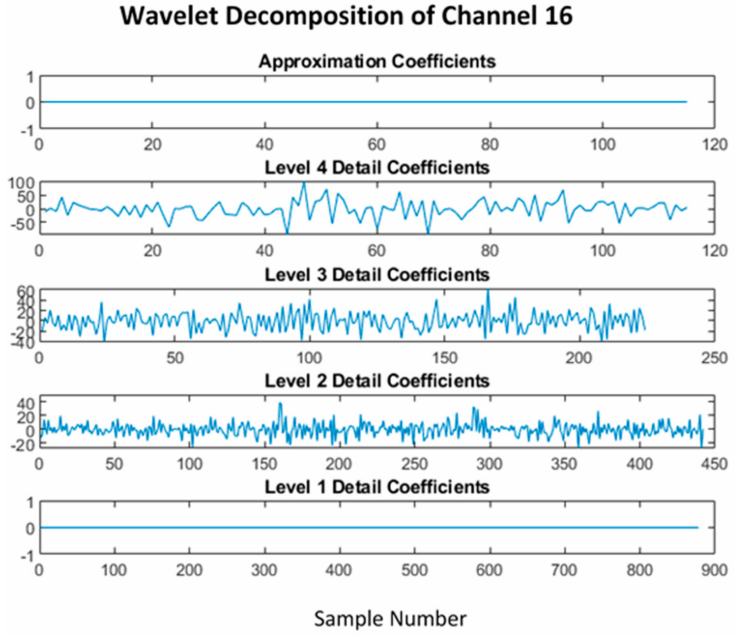
Figure 16. Wavelet decomposition with both approximation and level 1 detail